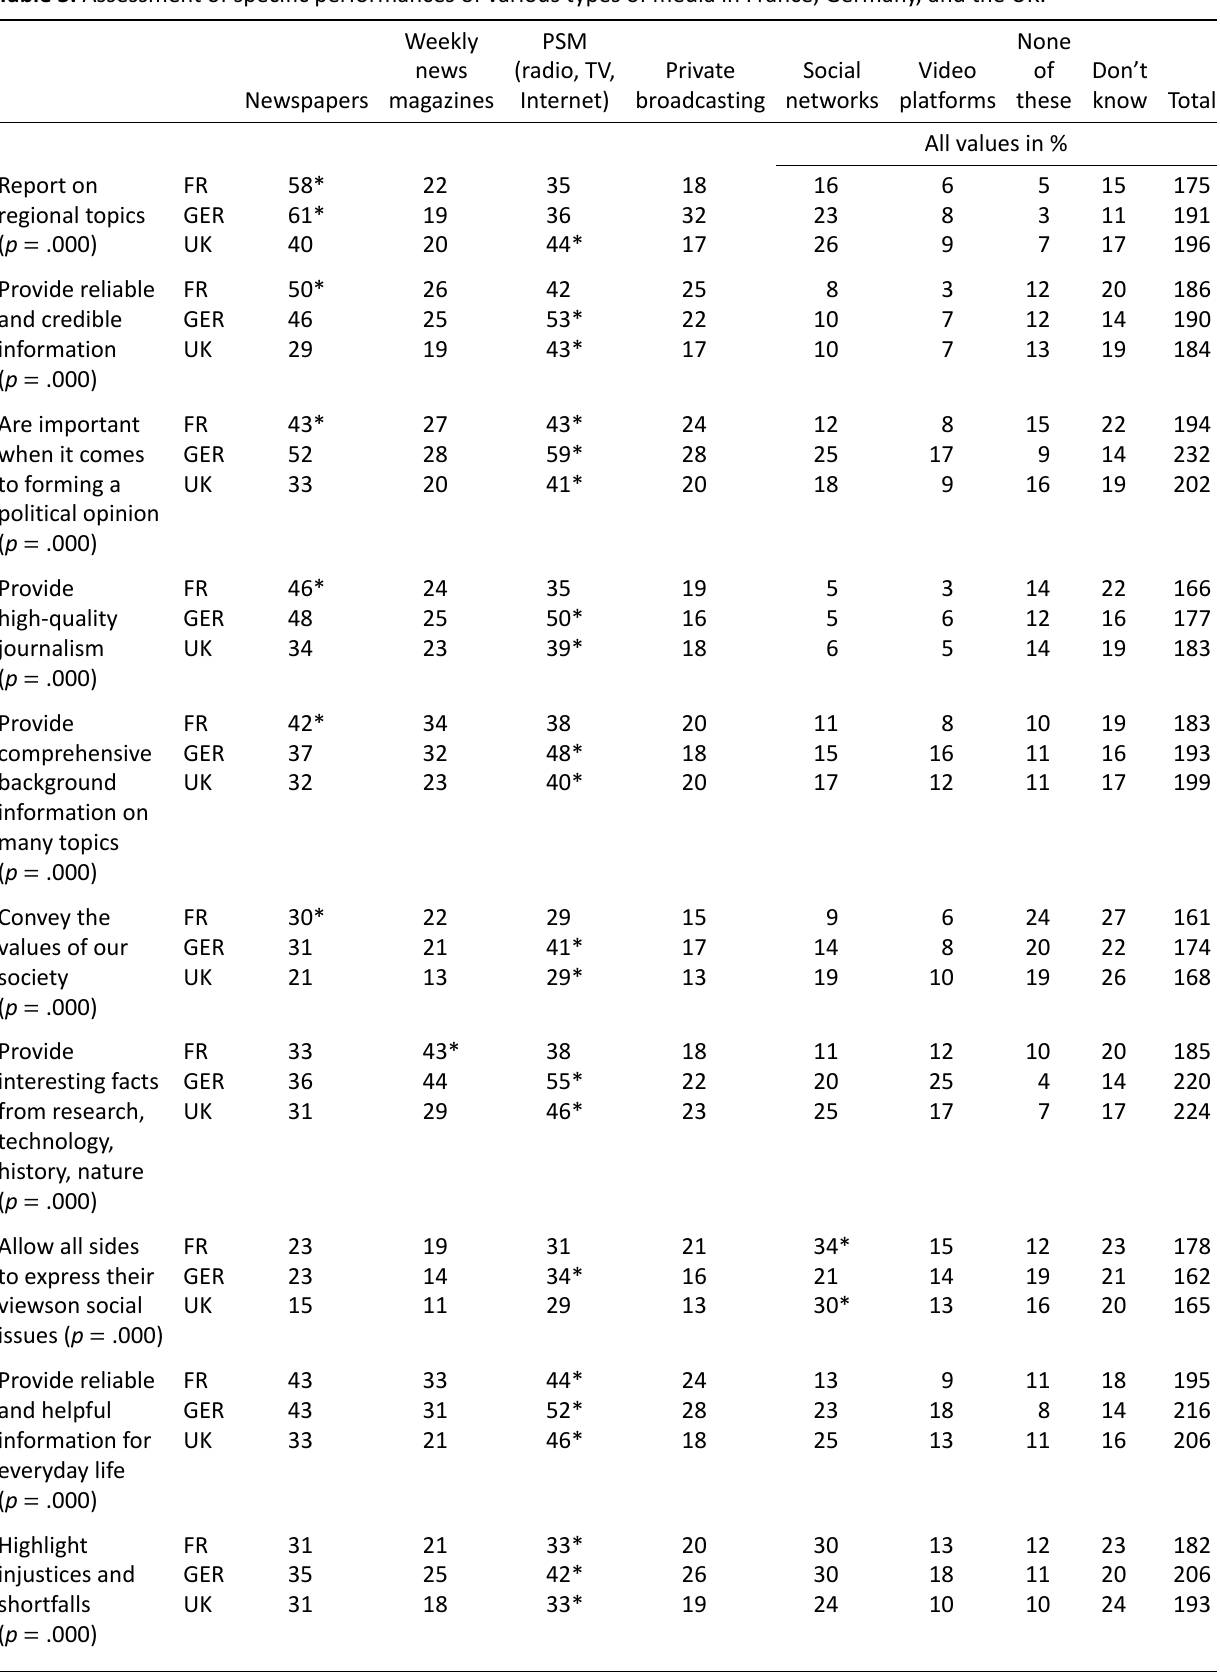
Table 3. Assessment of specific performances of various types of media in France, Germany, and the